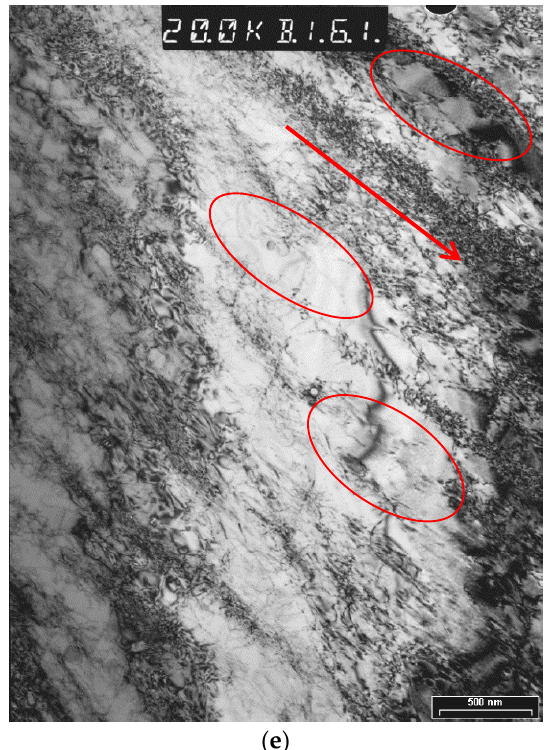
Figure 5. ( a ) TEM image of S31673, 14% CW taken from unloaded head of fatigue sample; ( b ) TEM image of CrMnN, 14% CW taken from unloaded head of fatigue sample; ( c ) TEM image of S31673, 14% CW taken from the gauge length of fatigued sample. ( d ) TEM image of CrMnN, 14% CW taken from the gauge length of fatigued sample. ( e ) TEM image of CrMnN, 14% CW taken from the gauge length of fatigued sample. No distinct glide bands are visible, but there is dislocation accumulation in one direction (red arrow). Red ellipses indicate the beginning of cell formation.